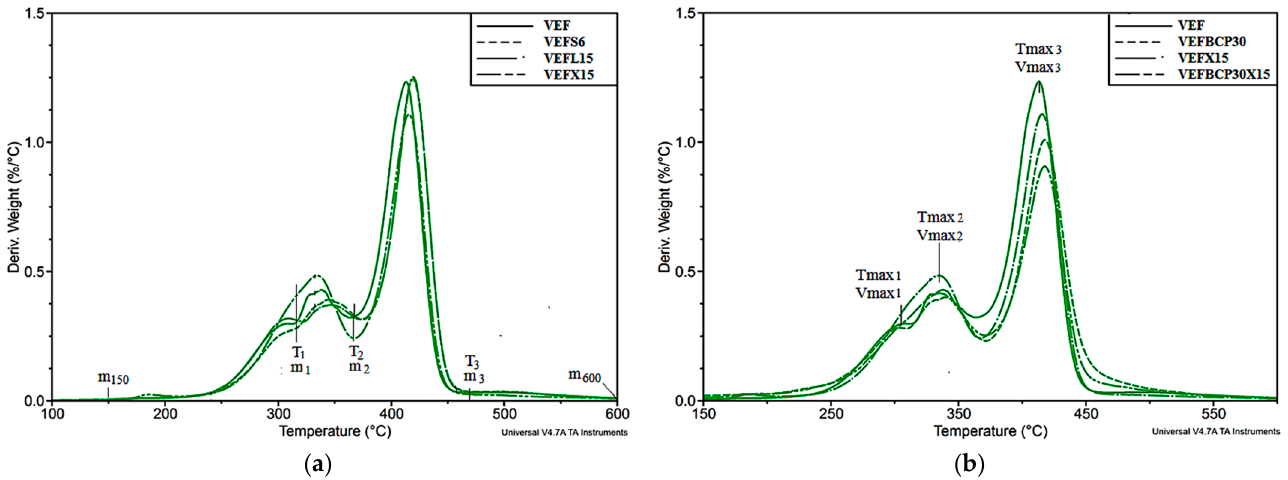
Figure 5. Mass change derivative curves (DTG) curves of VEF foams containing: ( a ) EG with different particle sizes, ( b ) BCP, EG X, and a mixture of BCP and EG X.